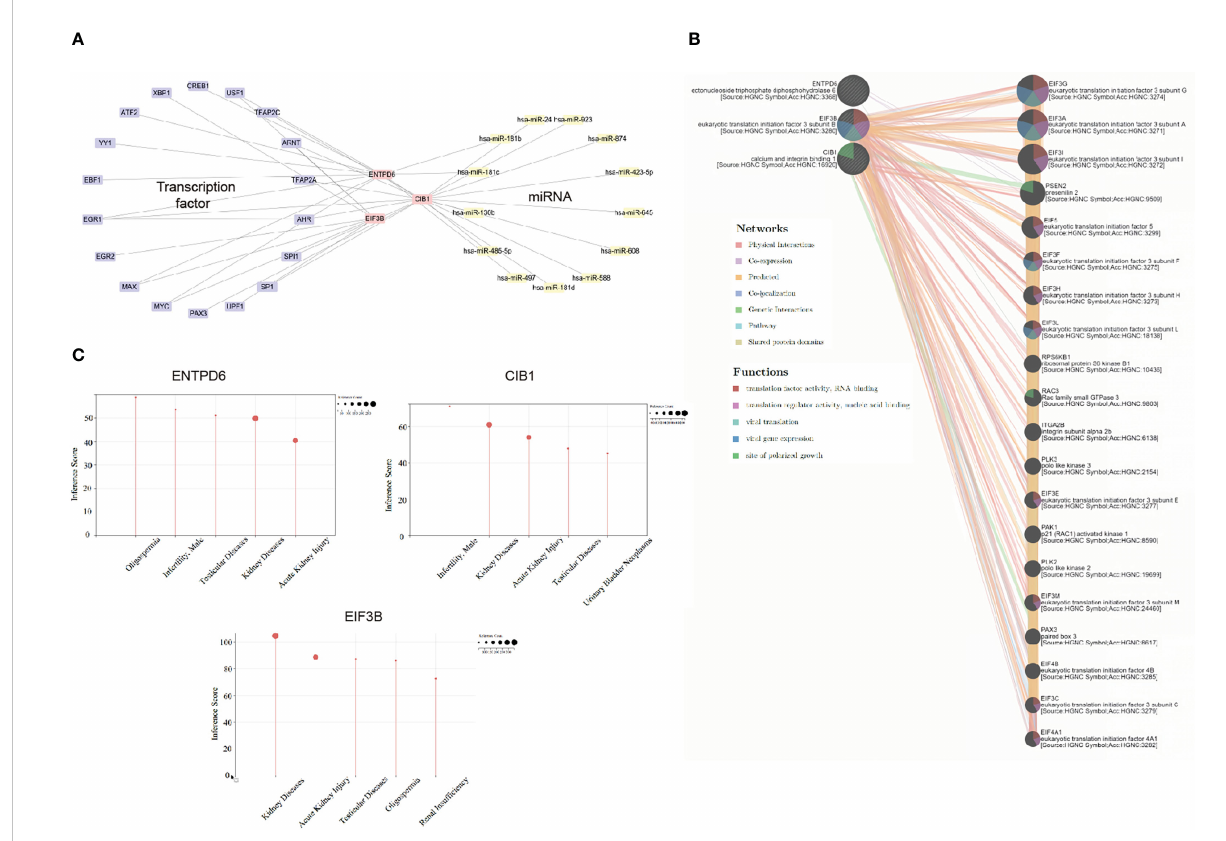
FIGURE 8 Transcriptional and post-transcriptional interaction, gene-gene interaction, and disease association analysis. (A) Transcriptional and post- transcriptional interaction network (including transcriptional factor and miRNA) visualized by Cytoscape. (B) Gene-gene interaction analysis using GeneMANIA. (C) Disease association analysis using CTD. CORGs, COVID-19-related differentially expressed genes; CTD, Comparative Toxicogenomics